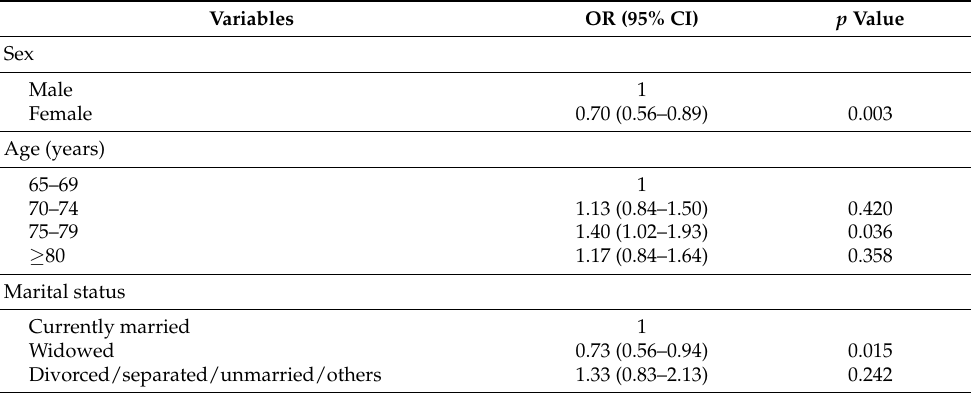
Table 2. Univariate analysis of factors associated with the presence of advance directives among older adults ( n =